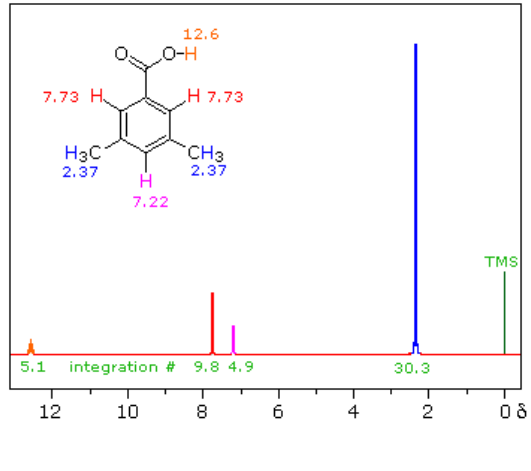
Figure 5 . Preprocessing NMR